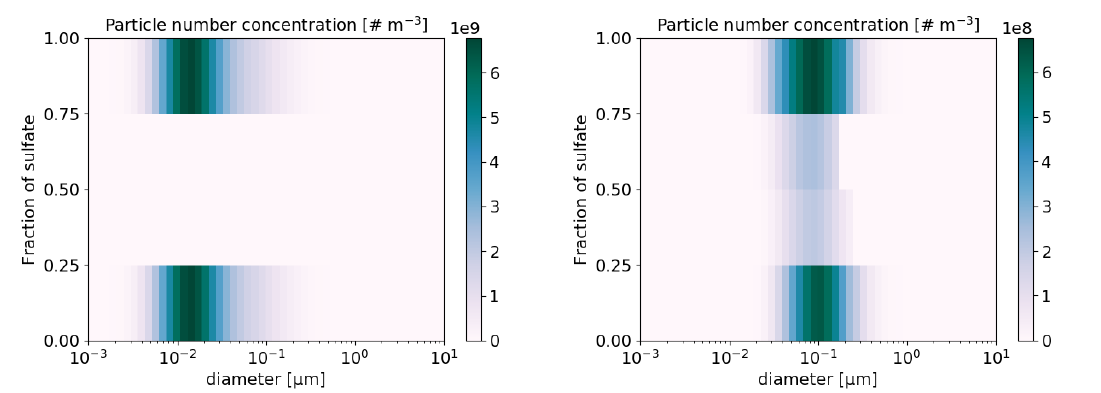
Figure 7. Particle number concentration (# m − 3 ) for the coagulation test case, as a function of size and composition: initial concentrations ( left ) and after 12 h of simulation ( right